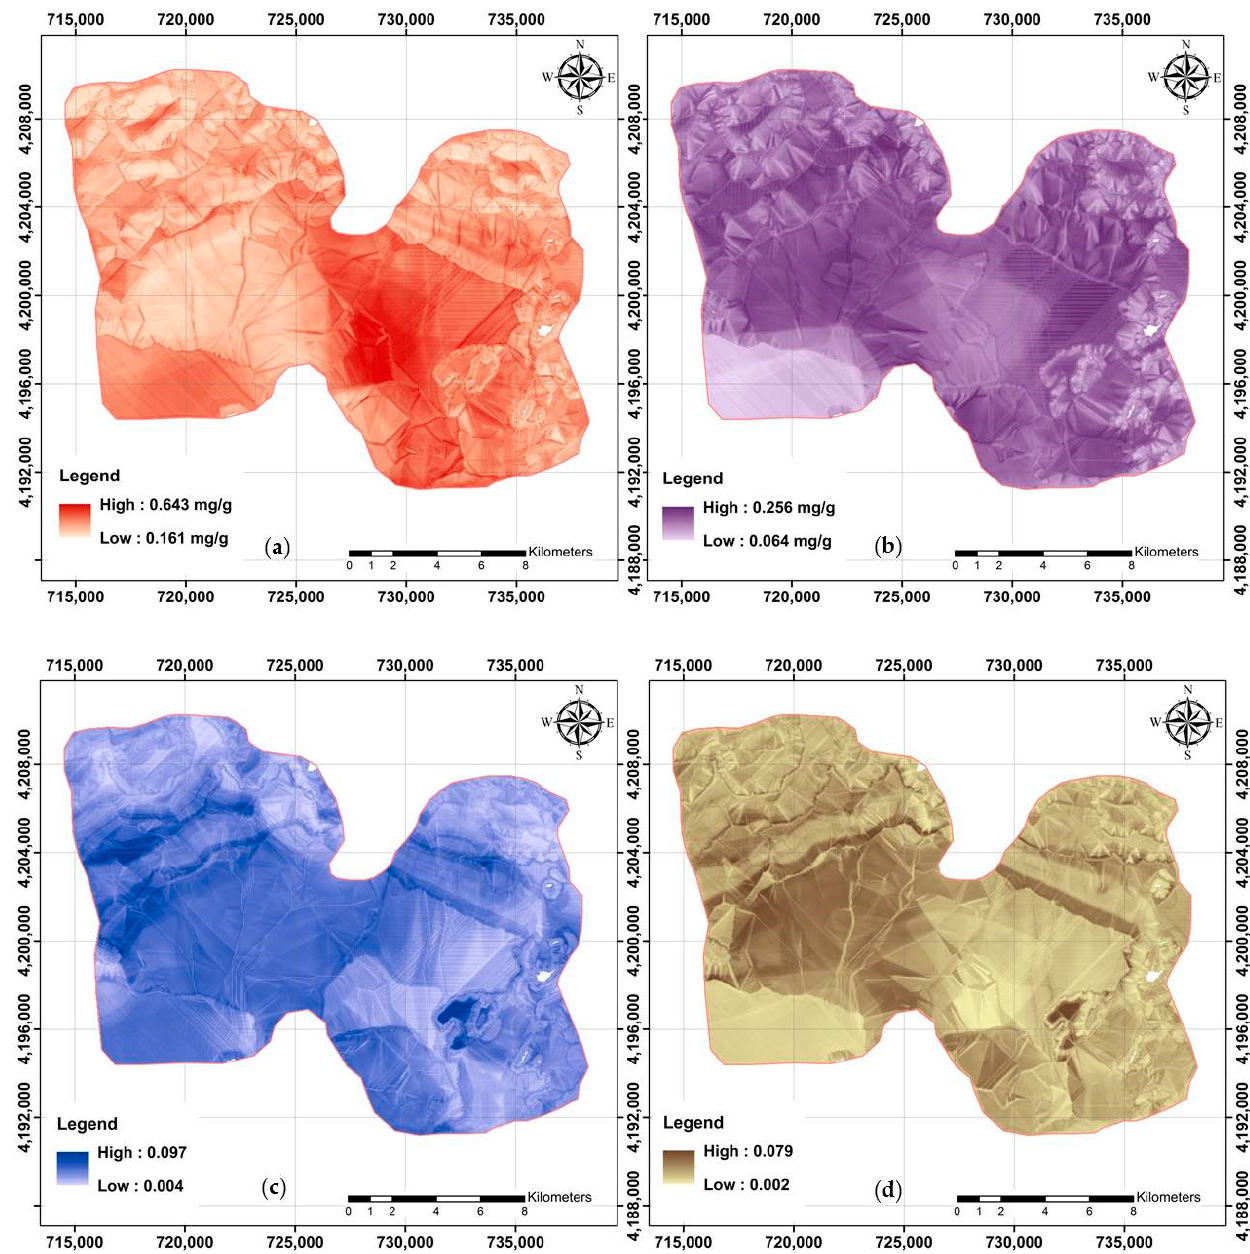
Figure 5. Final digital maps using RF model and available covariates: ( a ) TG; ( b ) EEG; ( c ) TG/OC; and ( d ) EEG/OC.